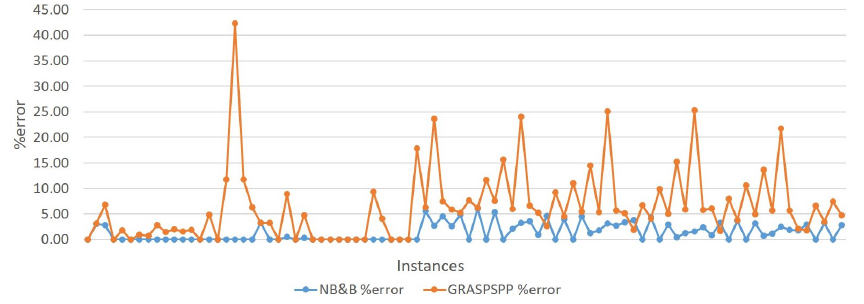
Figure 12. GAP comparison between GRASPSPP and NB&B algorithm.